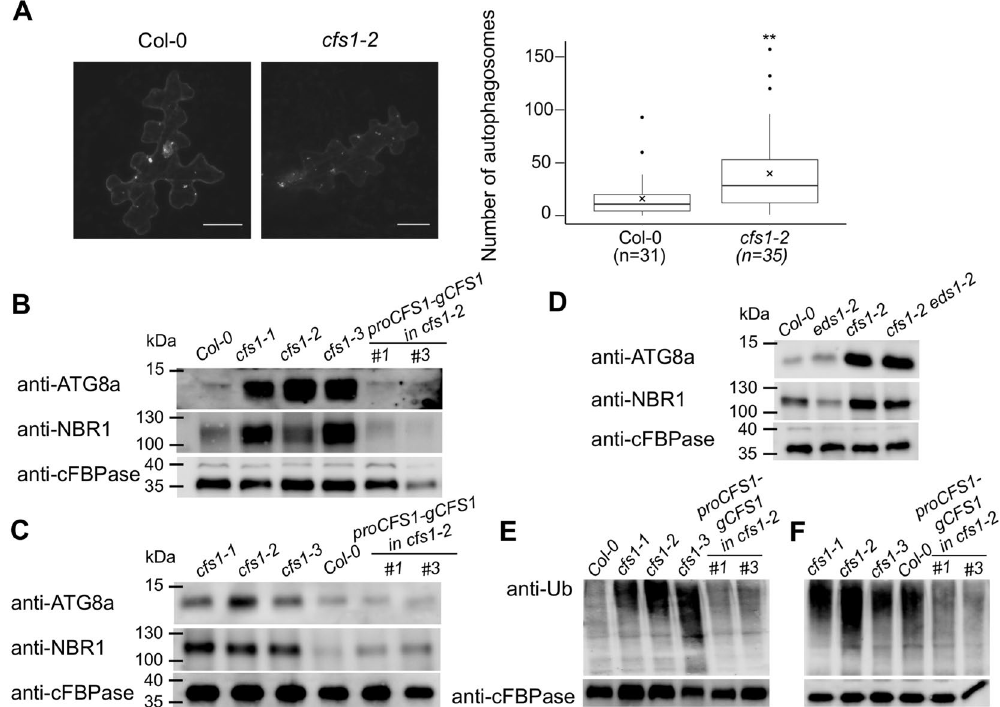
Figure 7. Autophagosomes are accumulated in cfs1 mutant. ( A ) Transiently expressed YFP-ATG8a in cfs1-2 epidermal leaf cells shows that YFP-ATG8a localized in punctate structures, indicating that autophagosomes can be formed. Scale bars are 25 µ m. Boxplots show significantly higher number of autophagosomes in cfs1-2 as compared to Col-0 (p ≤ 0.01 from Wilcoxon rank sum test). Straight lines within boxes represent median, crosses represent mean value, and outliers are depicted as closed circles. n indicates the number of cells used in the analysis. ( B ) Immunoblots of anti-ATG8a and anti-NBR1 reveal autophagosome accumulation in leaf 1 and 2 of three-week old cfs1 mutants compared to Col-0 and the complemented lines of the same stage. Anti-cFBPase is used as loading control. Full-length blots are presented in Supplementary Figure S9. ( C ) Immunoblots of anti-ATG8a and anti-NBR1 reveal autophagosome accumulation in leaf 1 and 2 of two-week old cfs1 mutants compared to Col-0 and the complemented lines of the same stage. Anti-cFBPase is used as loading control. Full-length blots are presented in Supplementary Figure S10. ( D ) Immunoblots of anti- ATG8a and anti-NBR1 reveal autophagosome accumulation in leaf 1 and 2 of two-week old cfs1-2 and cfs1-2 eds1-2 mutants compared to Col-0 and eds1-2 of the same stage. Anti-cFBPase is used as loading control. Full-length blots are presented in Supplementary Figure S11. ( E ) Immunoblot of anti-Ub reveals substantial accumulation of ubiquitinated proteins in leaf 1 and 2 of three-week old cfs1 mutants compared to Col-0 and the complemented lines of the same stage. Anti-cFBPase is used as loading control. Full-length blots are presented in Supplementary Figure S12. ( F ) Immunoblot of anti-Ub reveals accumulation of ubiquitinated proteins in leaf 1 and 2 of two-week old cfs1 mutants compared to Col-0 and the complemented lines of the same stage. Anti- cFBPase is used as loading control. Full-length blots are presented in Supplementary Figure